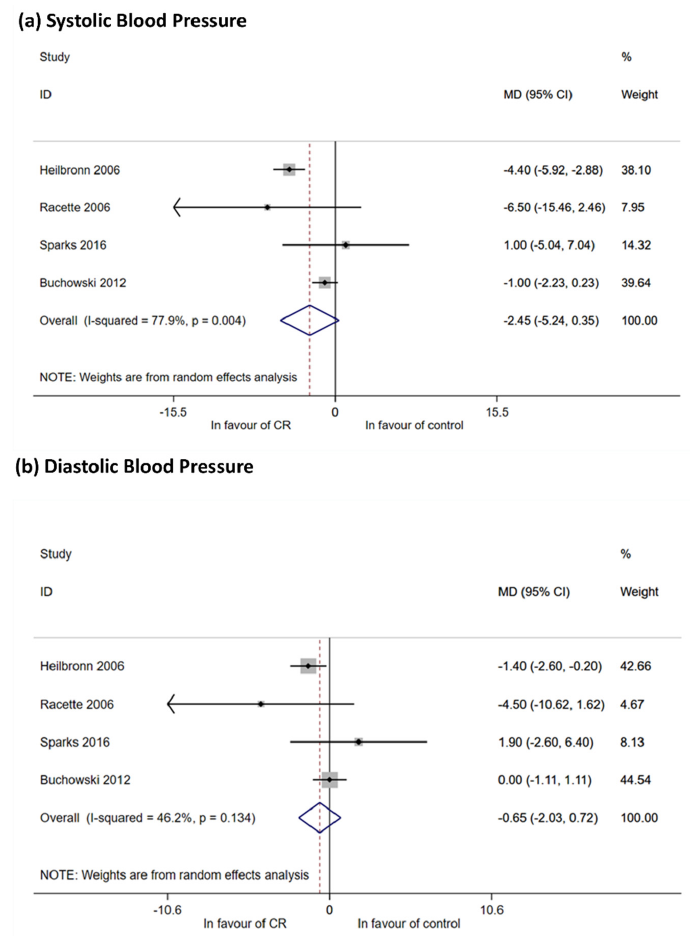
Figure 2. Meta-analysis for systolic (SBP) and diastolic blood pressure (DBP). ( a ) Meta-analysis using random effect method, outcome SBP. Meta-analysis was performed using post mean value (or median value) or mean change within groups and calculating mean differences (with their 95% CI). Four RCTs reported sufficient data for quantitative synthesis show a reduction of SBP among intervention participants, but 95% CI includes non-difference value (zero). Heterogeneity is high. All mean differences (MD) are expressed in mmHg; ( b ) meta-analysis using random effect method, outcome DBP. Meta-analysis was performed using post mean value (or median value) or mean change within groups and calculating mean differences (with their 95% CI). Meta-analysis with all four studies included shows none effect on DBP reduction. Heterogeneity is moderate. All MDs are expressed in mmHg.